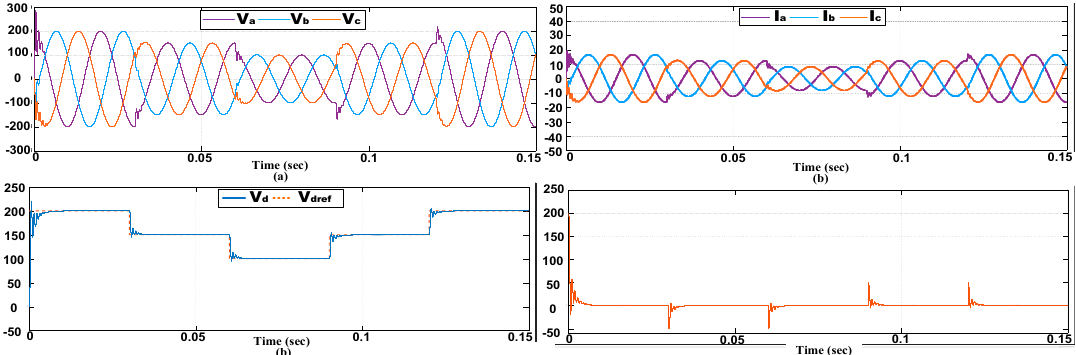
Figure 13. Simulation results with the DB predictive controller in transient condition. ( a ) Output voltage, ( b ) Load current, ( c ) α -frame voltage waveform, ( d ) Voltage tracking error.